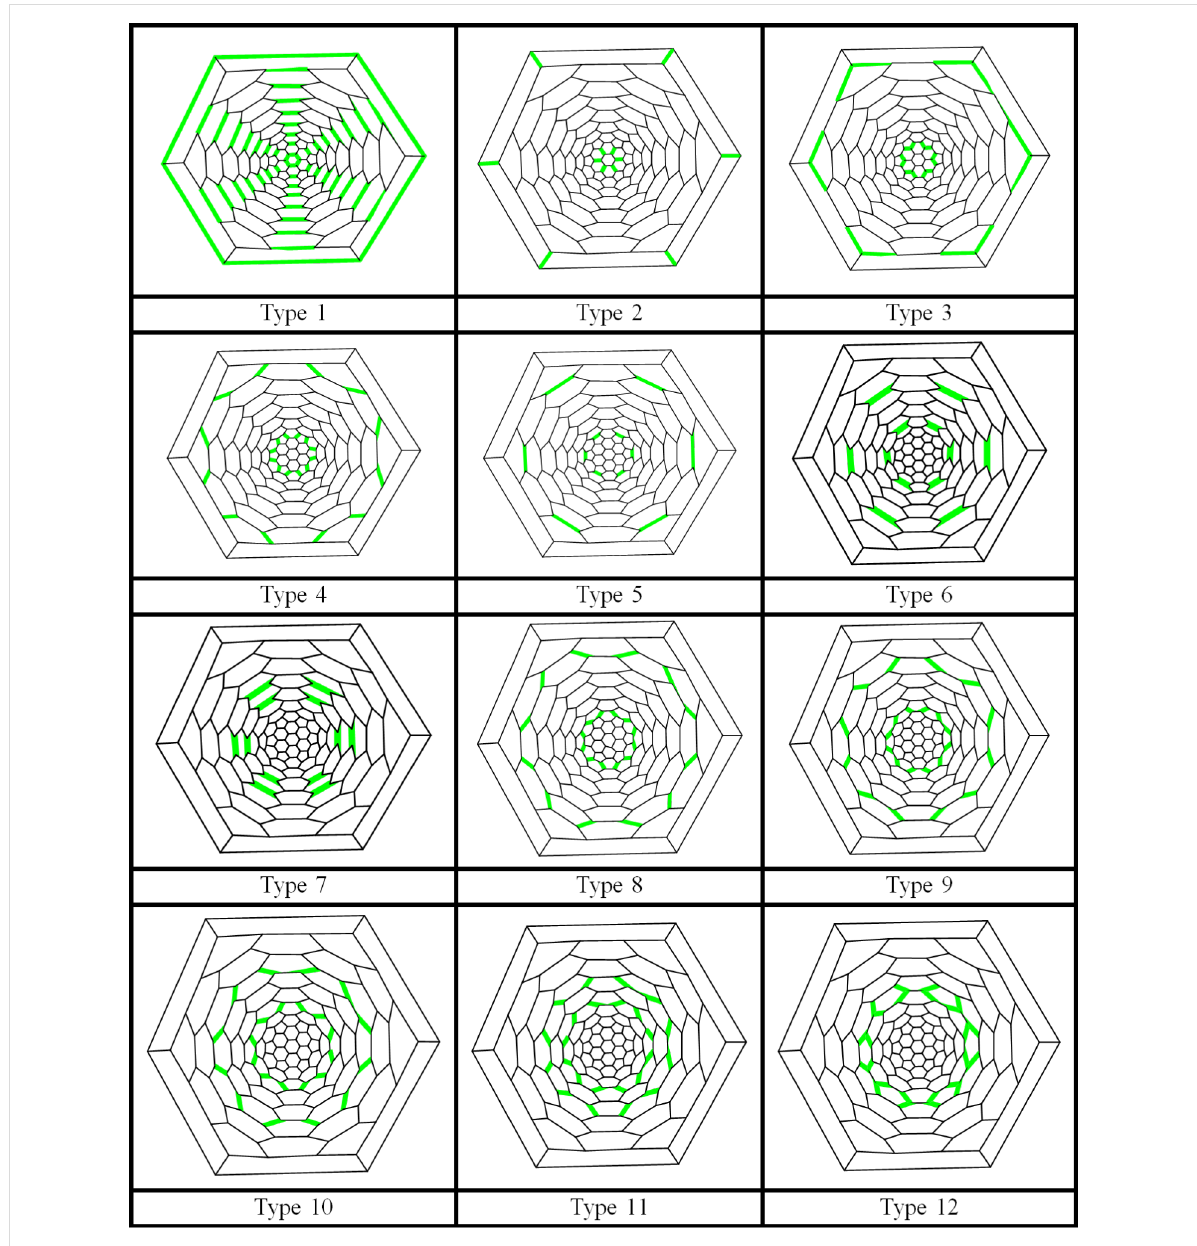
Figure 3: Twelve different types of edges of F n , n is